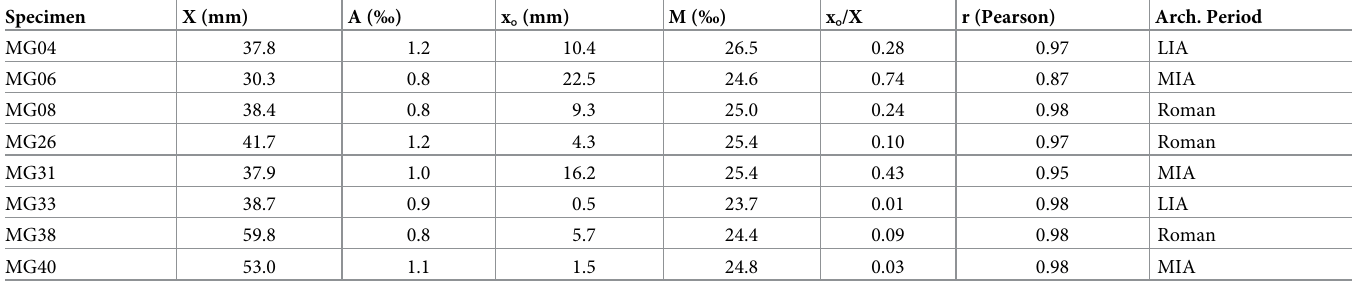
X: period of the cycle/length of tooth crown potentially formed over one annual cycle; A: amplitude; M: mean; x 0 : position in the tooth crown where δ 18 O has the highest value; r: the proximity between the modelled data and the measured δ 18 O values.